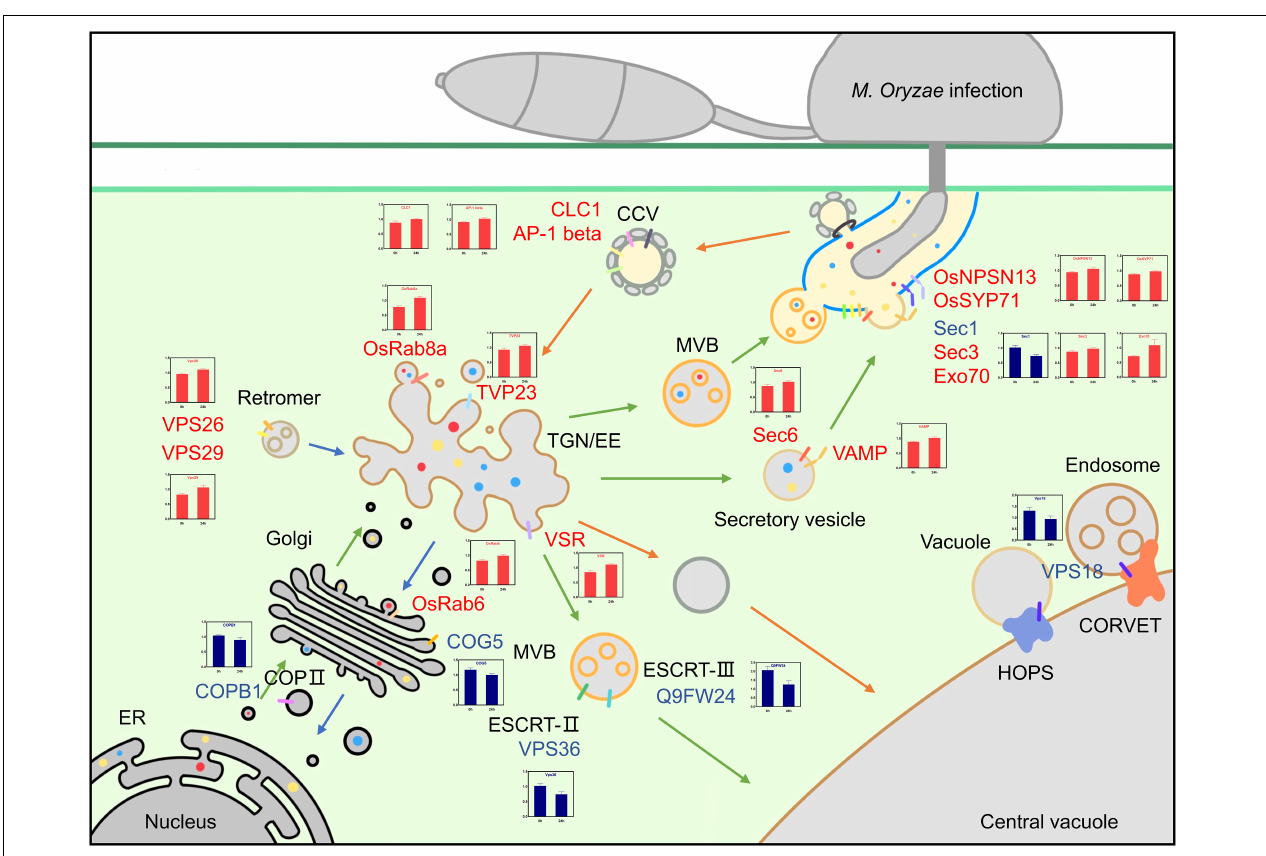
FIGURE 8 | Overview of the possible vesicle trafficking network of DEPs. Possible model for the roles of DEPs in vesicle trafficking during the rice-blast fungus interaction. Upregulated DEPs are shown in red, downregulated DEPs are shown in blue, green arrows indicate exocytosis, orange arrows indicate endocytosis, and the translational patterns of DEPs are shown in the